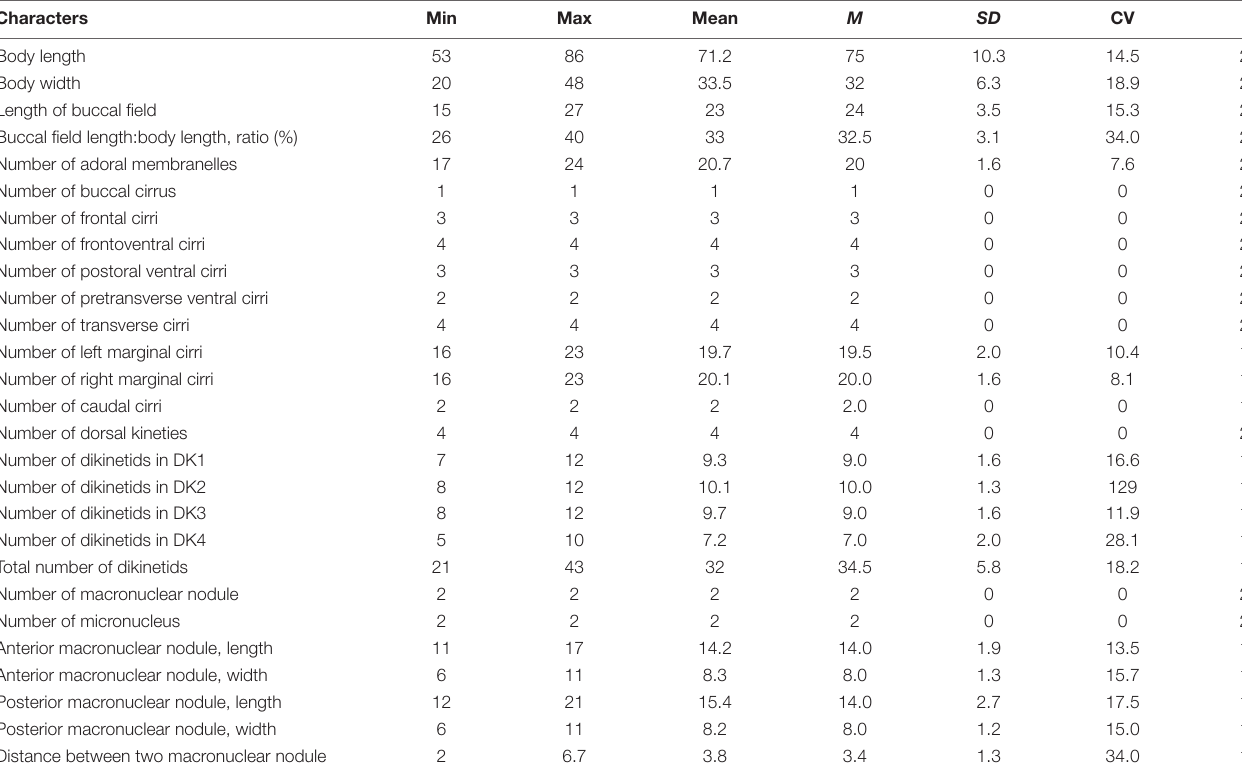
TABLE 1 | Morphometric data on Hemiurosomoida tibetensis sp. nov.